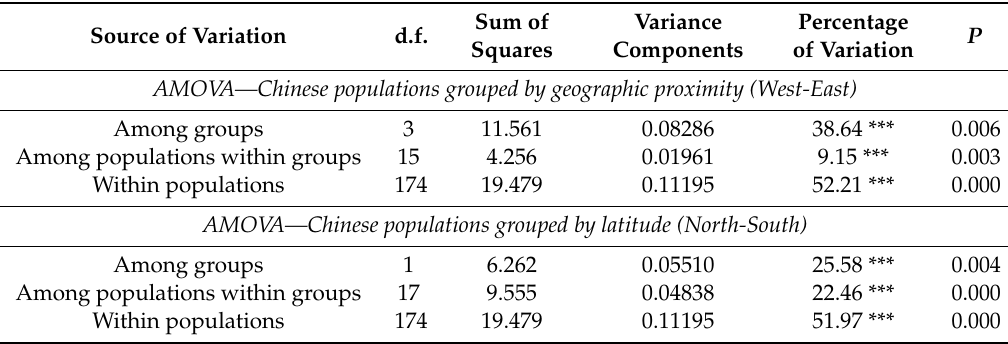
Table 2. AMOVA analysis of genetic variation.